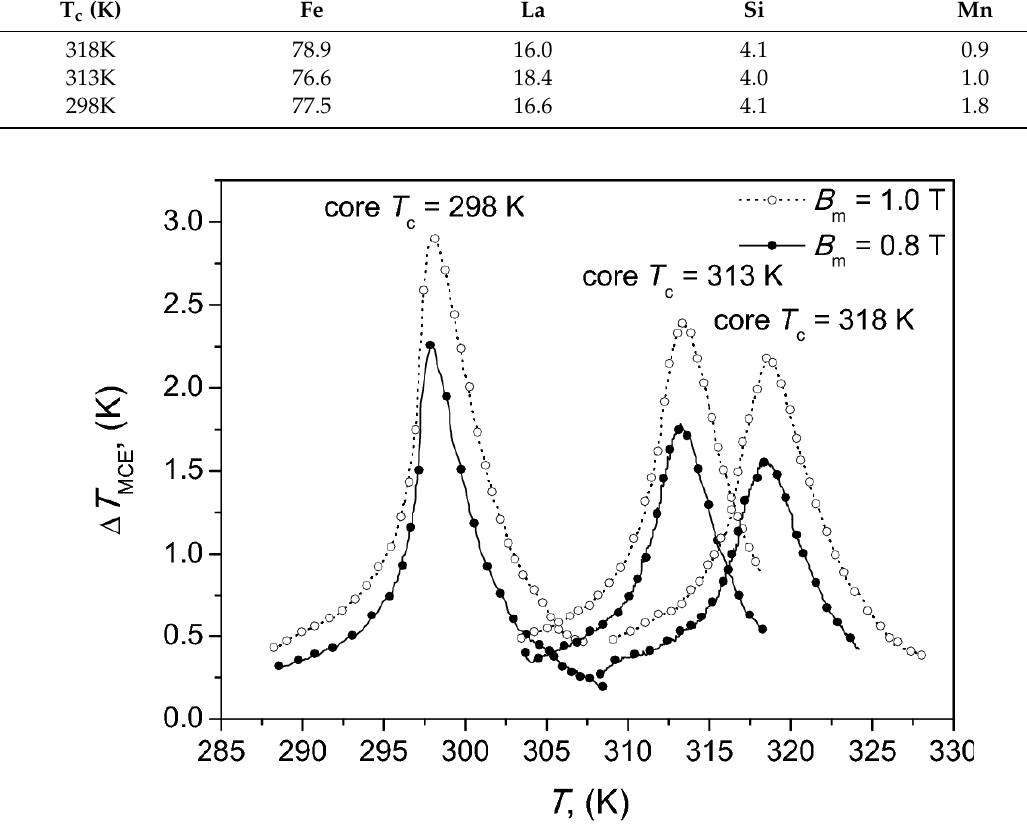
Figure 3. Influence of temperature and magnetic field on the induced magnetocaloric effect (MCE) of the examined samples with La(FeMnSi) 13 -H x composition.